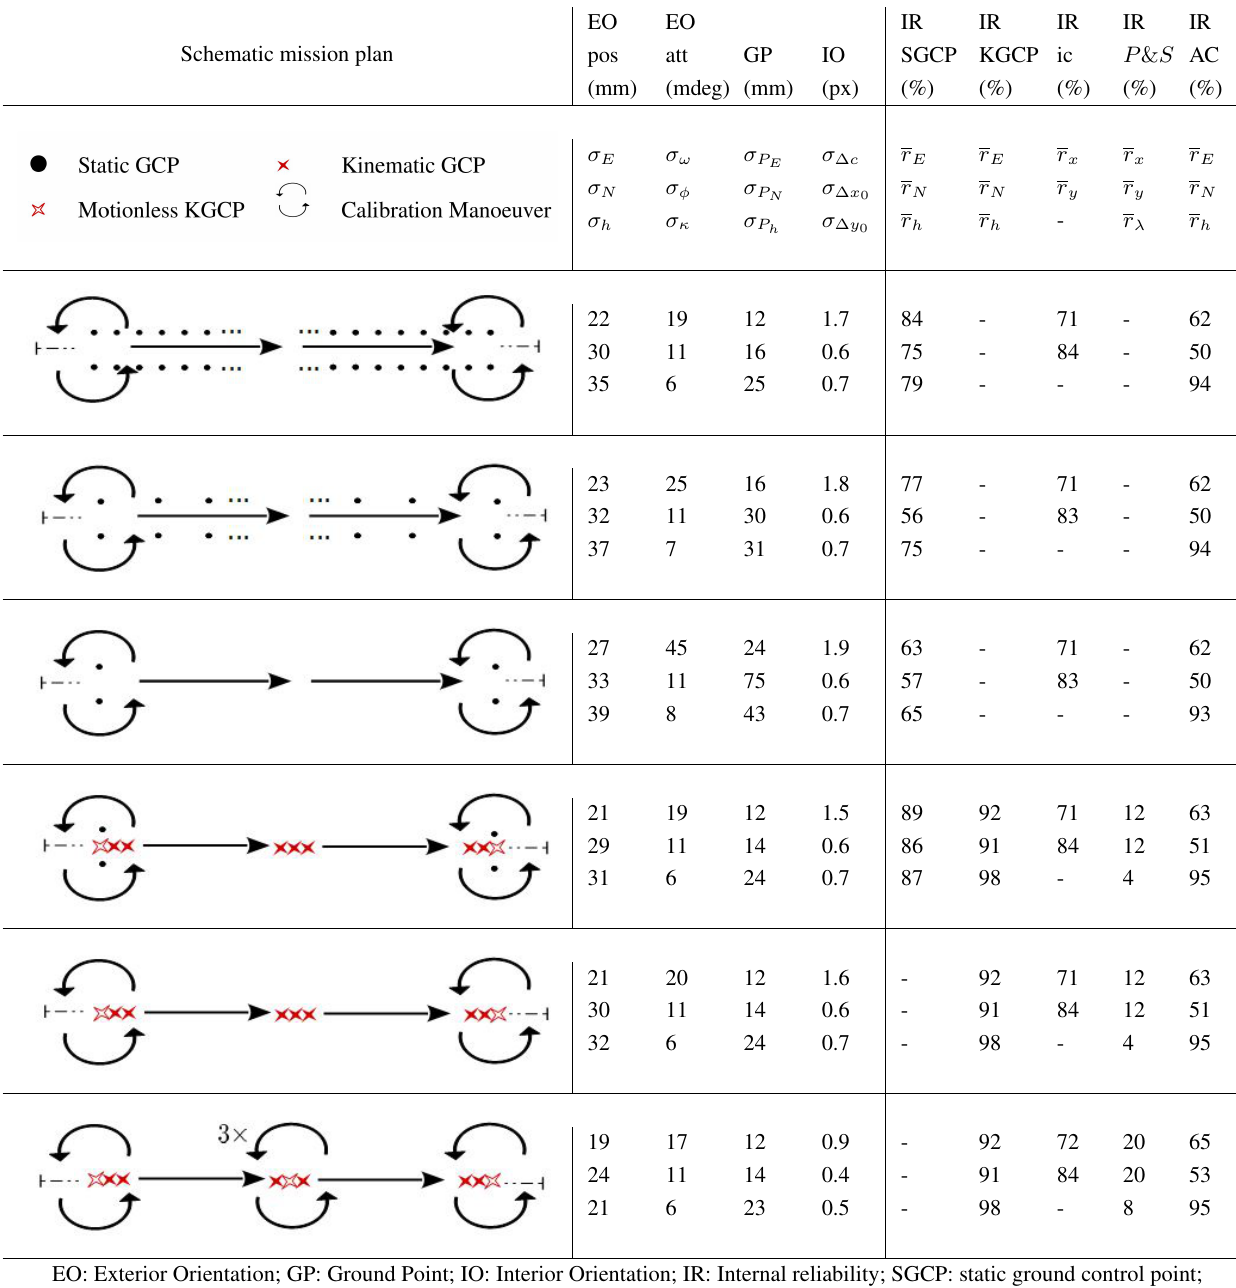
Table 3: Precision and internal reliability results for the mapKITE corridors, varying SGCPs, KGCPs and calibration manoeuvers.